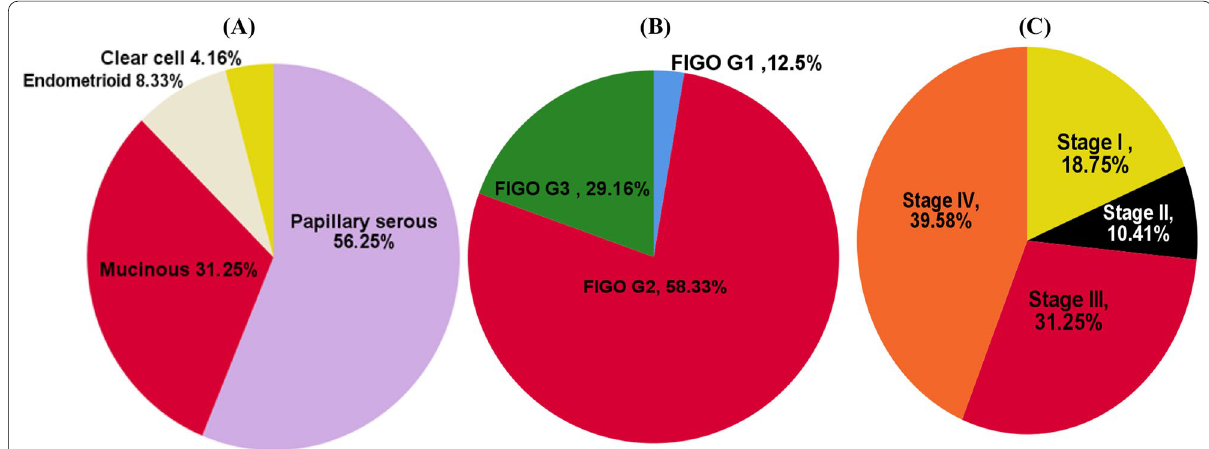
Fig. 2 Clinicopathological profiles of ovarian cancer. Pie charts showing distribution of various parameters in ovarian cancer A Histological types, B FIGO grading, and C FIGO